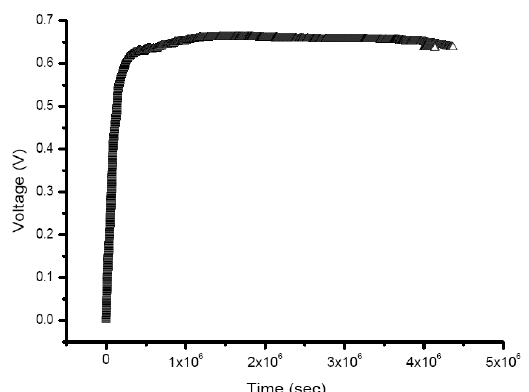
Figure 2. Variation of voltage across the external load of the 10F capacitor.